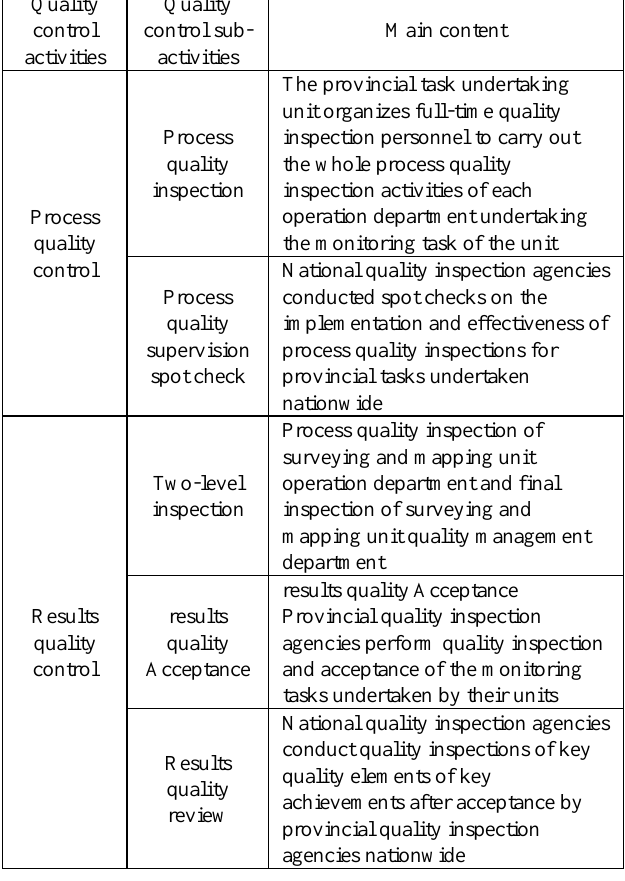
Figure 1.Production technology